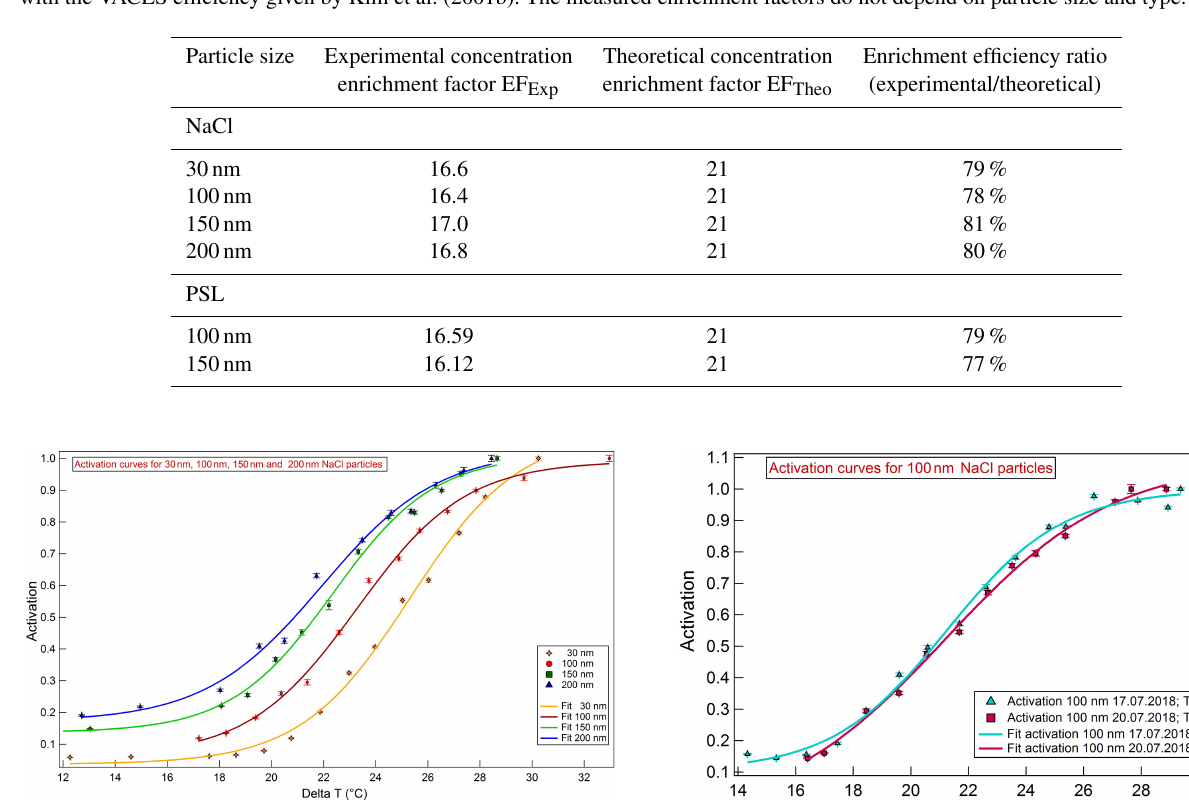
Table 2. Comparison between the measured experimental enrichment factors for NaCl and PSL particles with different sizes to the calculated theoretical enrichment factor. The measured enrichment factor corresponds to roughly 80% of the theoretical enrichment factor, which agrees with the VACES efficiency given by Kim et al. (2001b). The measured enrichment factors do not depend on particle size and type.